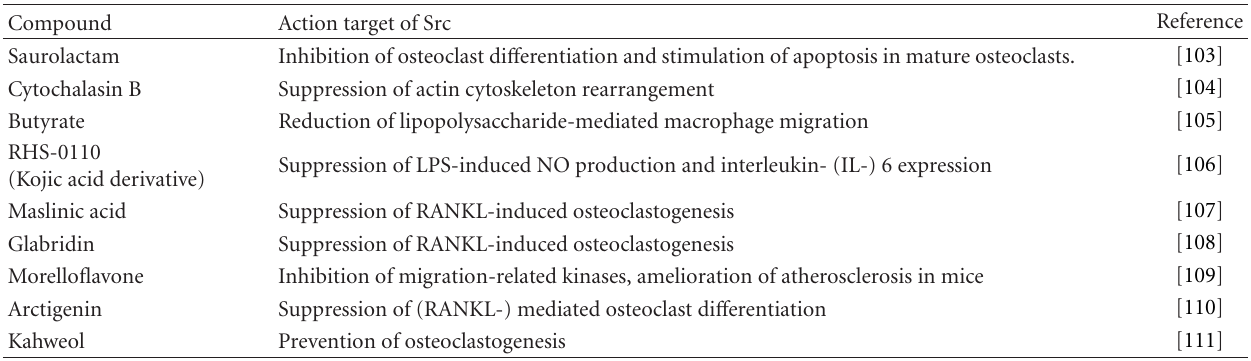
Table 5: Naturally occurring compounds inhibiting Src pathway activation in